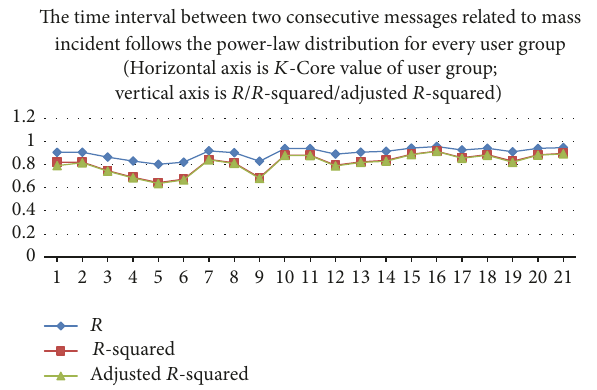
The time interval between two consecutive messages related to mass incident follows the power-law distribution for every user group (Horizontal axis is K -Core value of user group; vertical axis is R / R -squared/adjusted R -squared)